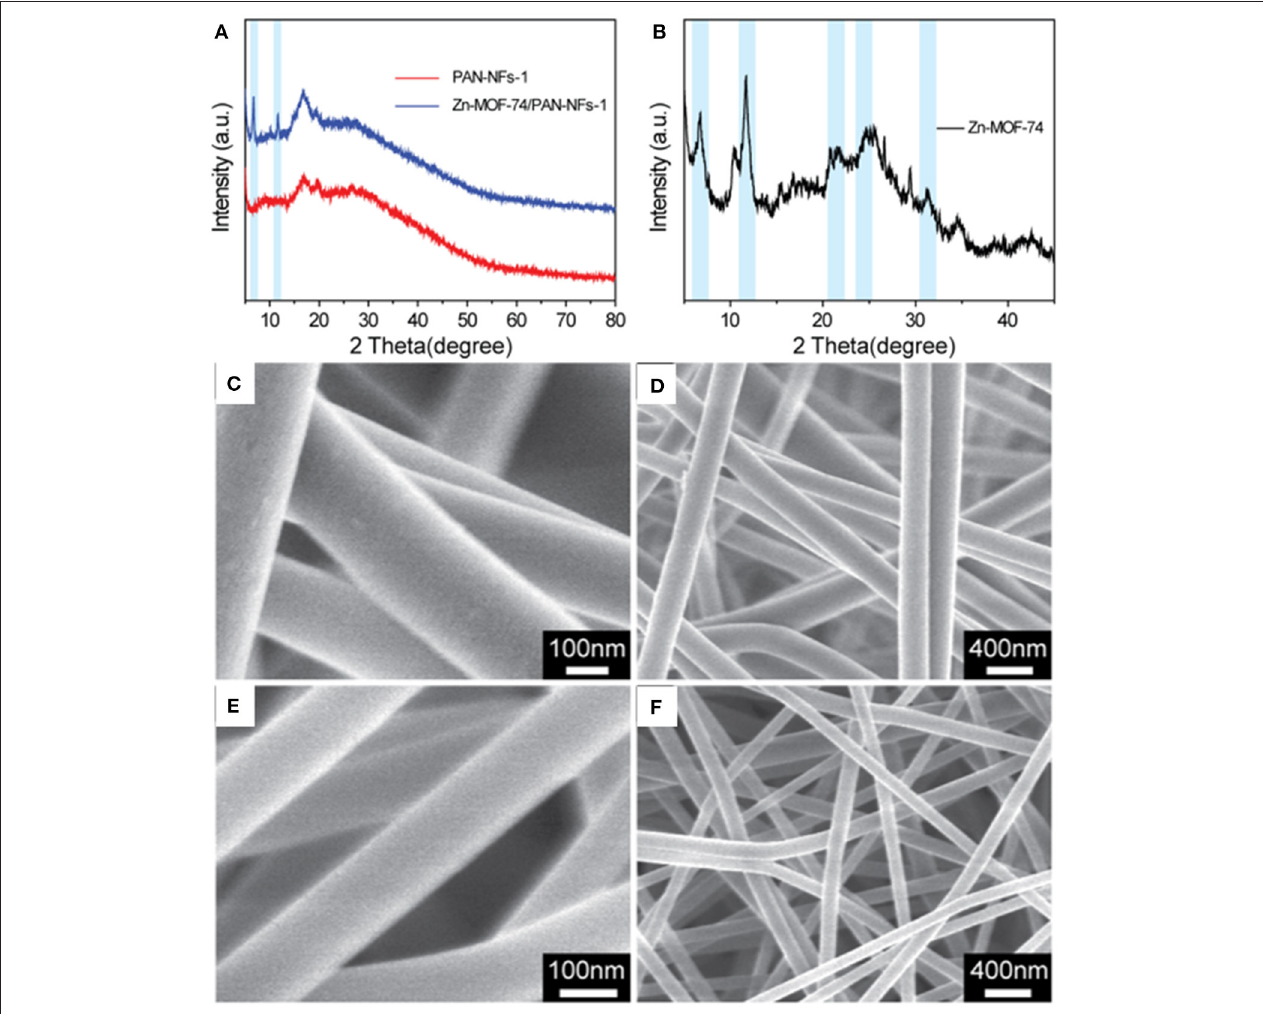
FIGURE 1 | (A) XRD patterns of PAN fibers and Zn–MOF-74/PAN composite fibers; (B) XRD patterns of Zn–MOF-74 obtained from dissolving Zn–MOF-74/PAN fibers using DMF; (C,D) SEM images of PAN fibers; (E,F) SEM images of Zn–MOF-74/PAN fibers.